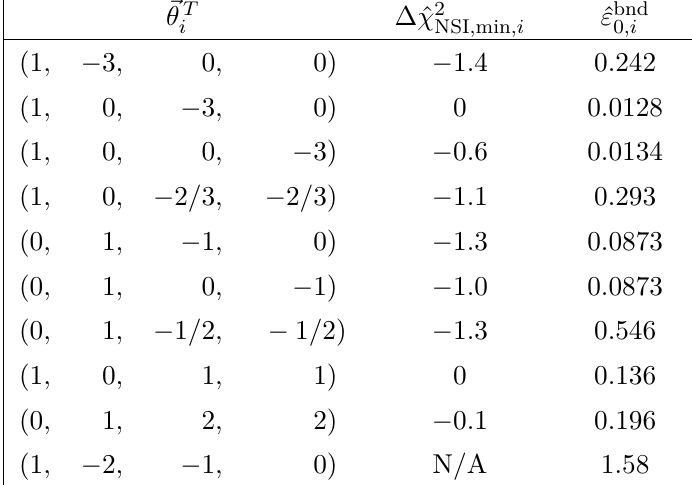
Table 2 . Input data from ref. [74] used for fitting the parameters of the approximate ∆ χ 2 The value of ˆ ε bnd for ~θ T = (1 , − 2 , − 1 , 0) has been provided by the authors of [74] in private 0 ,i i communication in the context of [65].